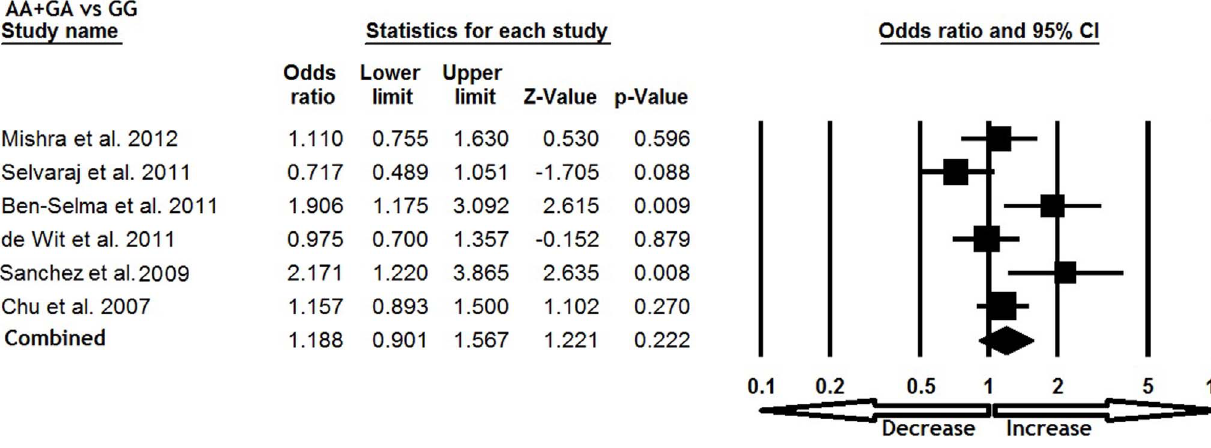
Figure 5. Forest plot and ORs with 95% CI of CCL5 -403G . A polymorphism and TB risk (AA + GA vs. GG).